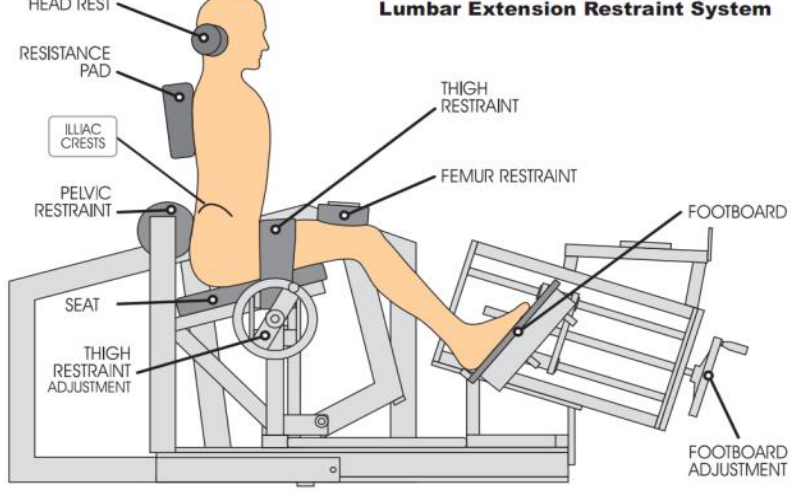
Figure 1. MedX schematic demonstrating the restraint system, thus isolating lumbar extensors [44].